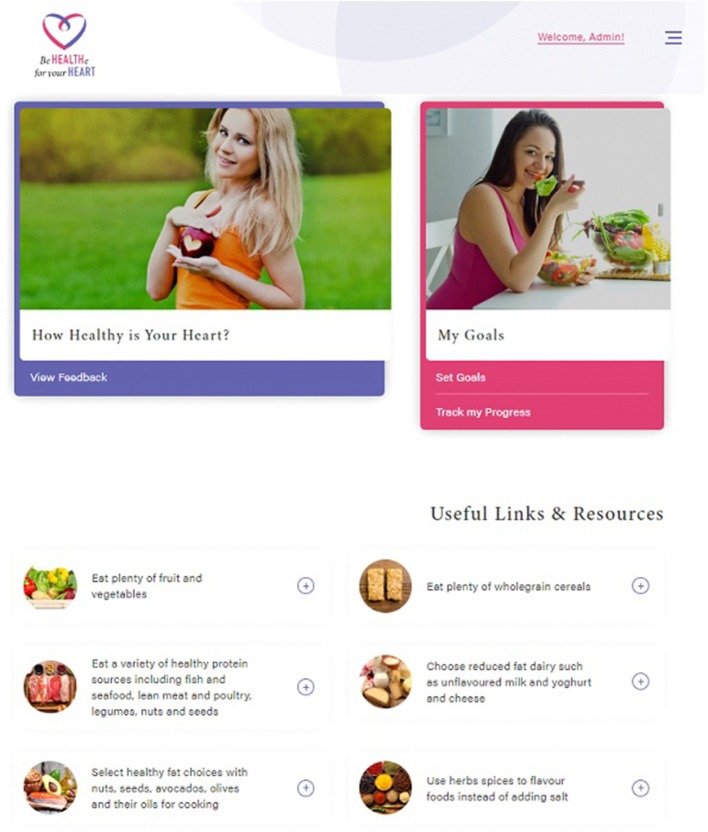
Be Healthe for your Heart website. All images are reprinted from shutterstock.com under a Standard License, with permission from Shutterstock.